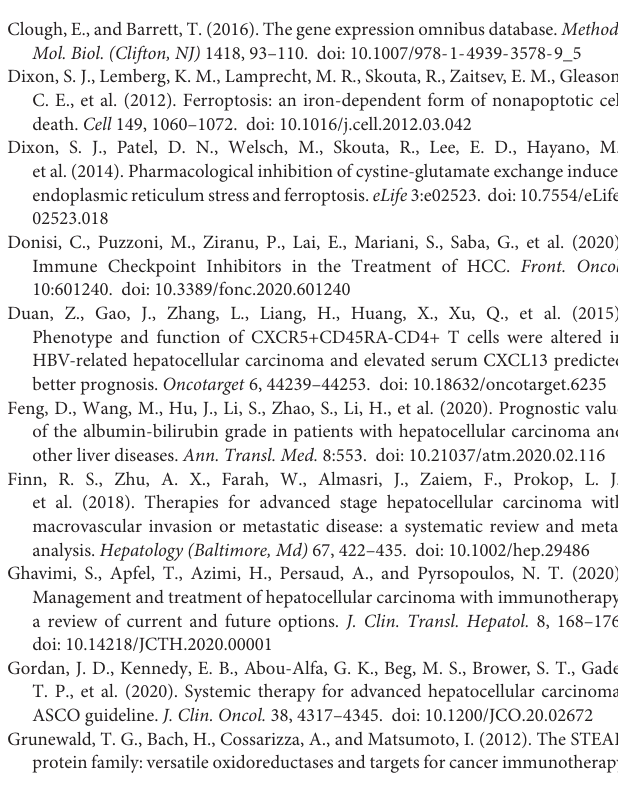
Supplementary Figure 1 | ROC analysis of STEAP3 for LIHC patients. ROC curve showed the potential diagnostic value of STEAP3 as a biomarker in distinguishing LIHC tissue from healthy tissue. X-axis means false positive rate while Y-axis indicates true positive rate. Supplementary Figure 2 | Correlation of STEAP3 expression with immunomodulators in LIHC. (A) The association between STEAP3 expression and immunostimulators. (B) The top four immunostimulators bearing a positive correlation with STEAP3 expression. (C) The association between STEAP3 expression and immunoinhibitors. (D) The top three immunoinhibitors bearing a negative correlation with STEAP3 expression. Supplementary Figure 3 | Correlation of STEAP3 expression with chemokines or chemokine receptors in LIHC. (A) The connection between STEAP3 expression and chemokines. (B) The top four chemokines displaying relation with STEAP3 expression. (C) The connection between STEAP3 expression and receptors. (D) The top three receptors displaying relation with STEAP3